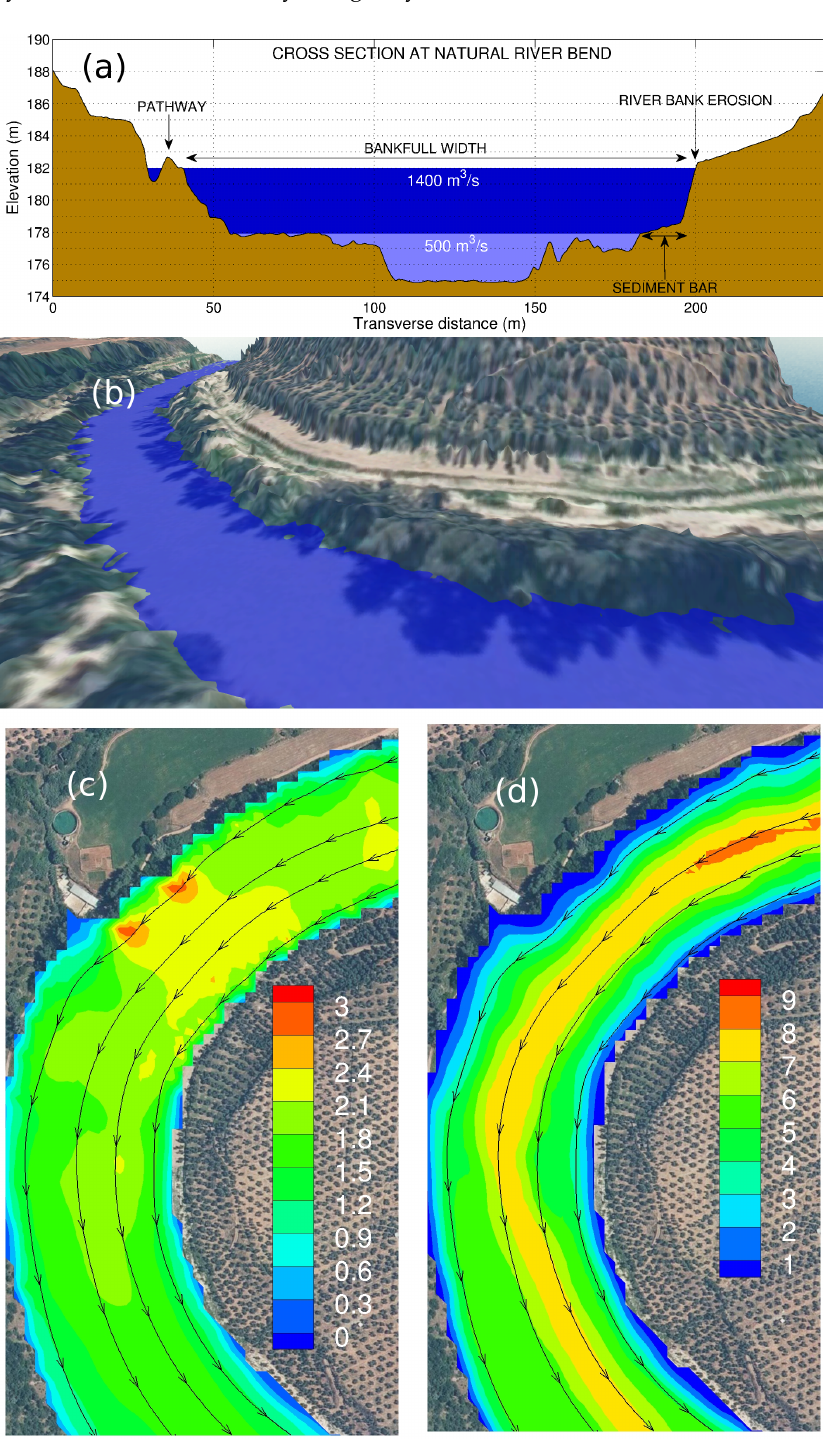
Figure 7. ( a ) Characteristic cross section at the natural river bend shown in Figure 4b–d. Flood levels for Q = 500 and 1400 m 3 · s − 1 are depicted in light and dark blue, respectively; ( b ) 3D view of the river bend (base flow level = 175 m) and sediment bar shown in Figure 5a. Panels ( c , d ) show simulated values of the velocity magnitude (m · s − 1 ) and the flow depth (m) with Q = 1400 m 3 · s − 1 ,